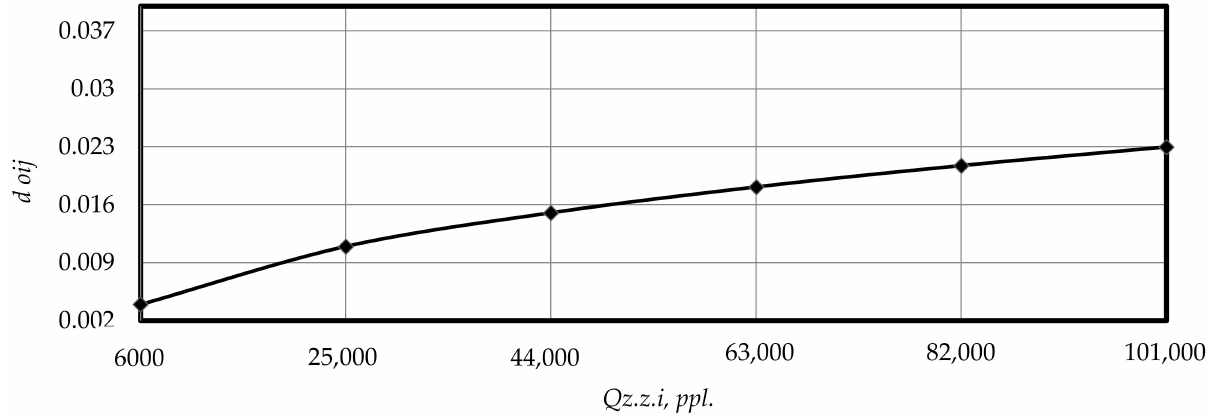
Figure 10. Graph of the change in trip distribution function of urban employers of city service enterprises depending on the number of inhabitants in the zone of